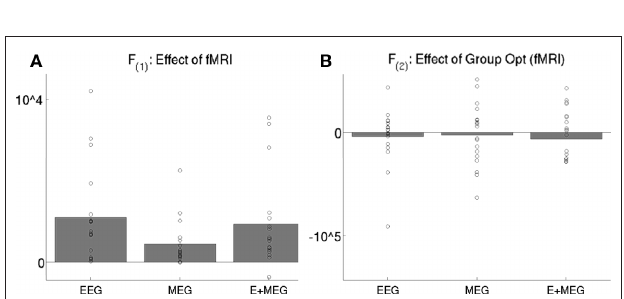
Figure 8 | The bars show the difference in the mean across subjects of the maximized free-energy bound on the model log-evidence (arbitrary units) for two models: with versus without the three fMri priors (A), or with versus without group-optimization of those priors (B), for eeg data alone, Meg data alone, or the combined eeg and Meg data. The circles show values for each subject’s difference. fMRI priors significantly improve the mean free-energy, but their group-optimization does not (as expected, see text). F